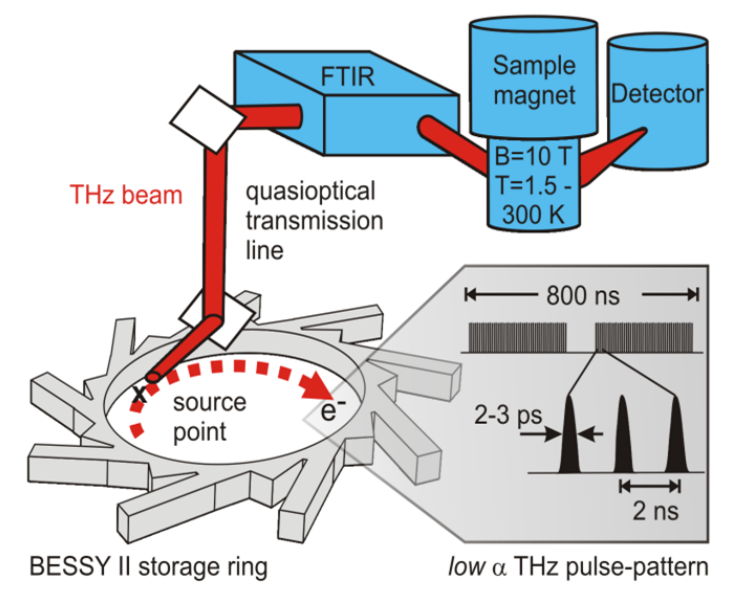
Figure 1: Schematic layout of the THz user station with the THz beam indicated in red. The insert shows the fill-pattern of the storage ring in low α